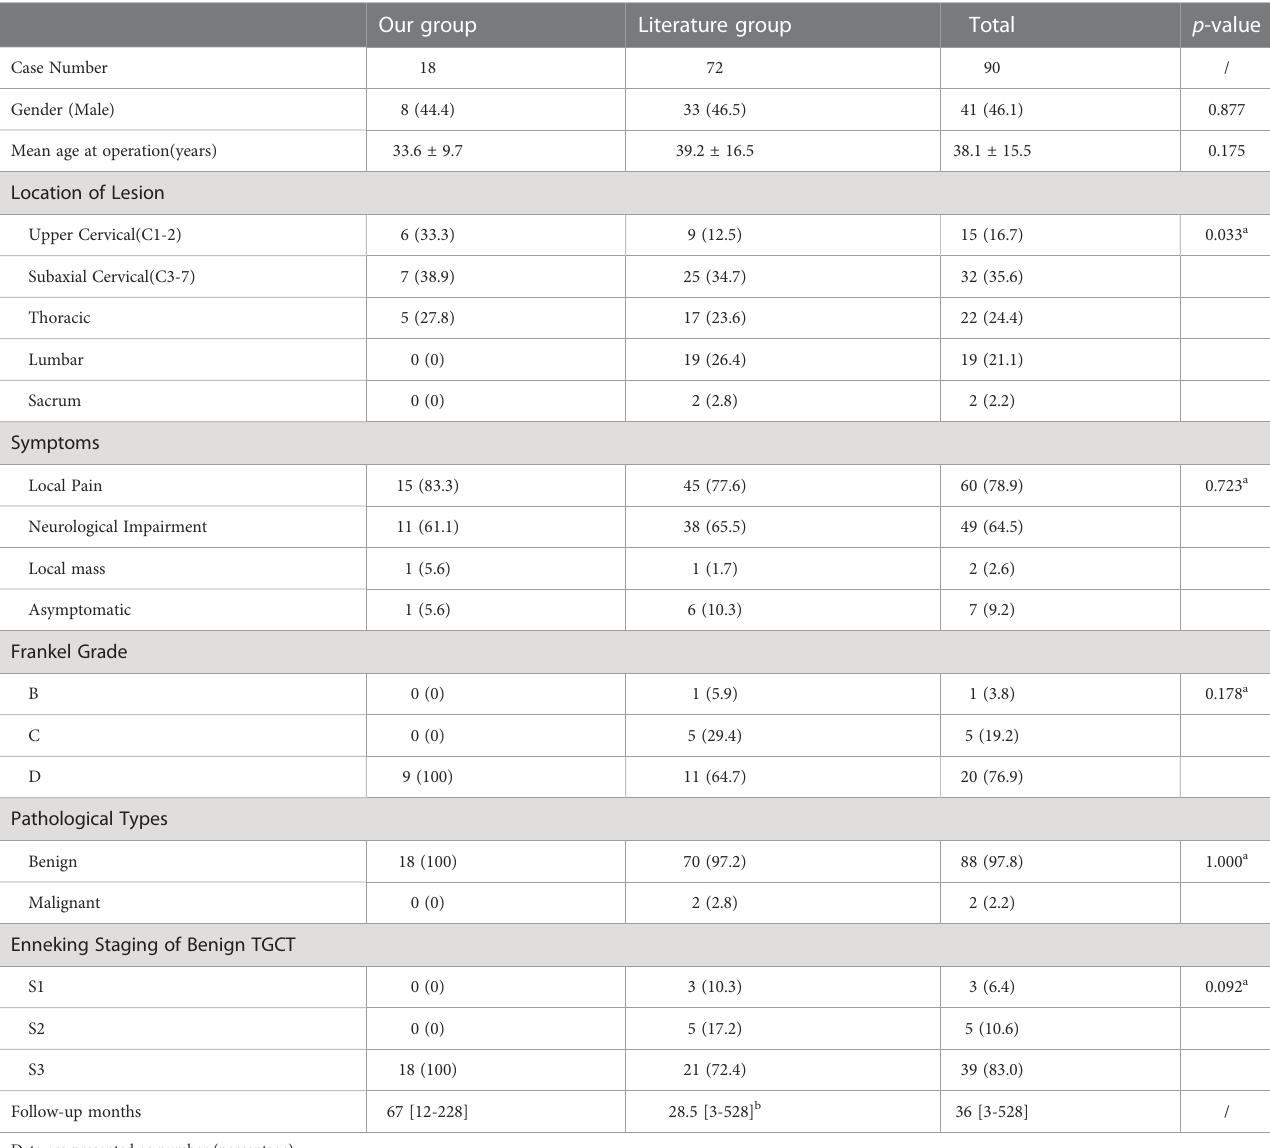
TABLE 2 Demographic and Clinical Characteristics.